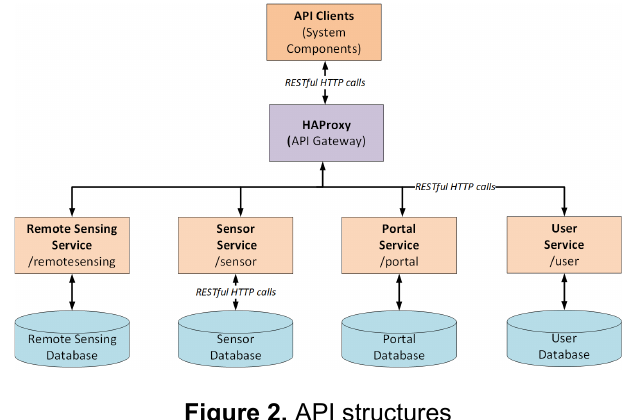
Figure 2. API structures